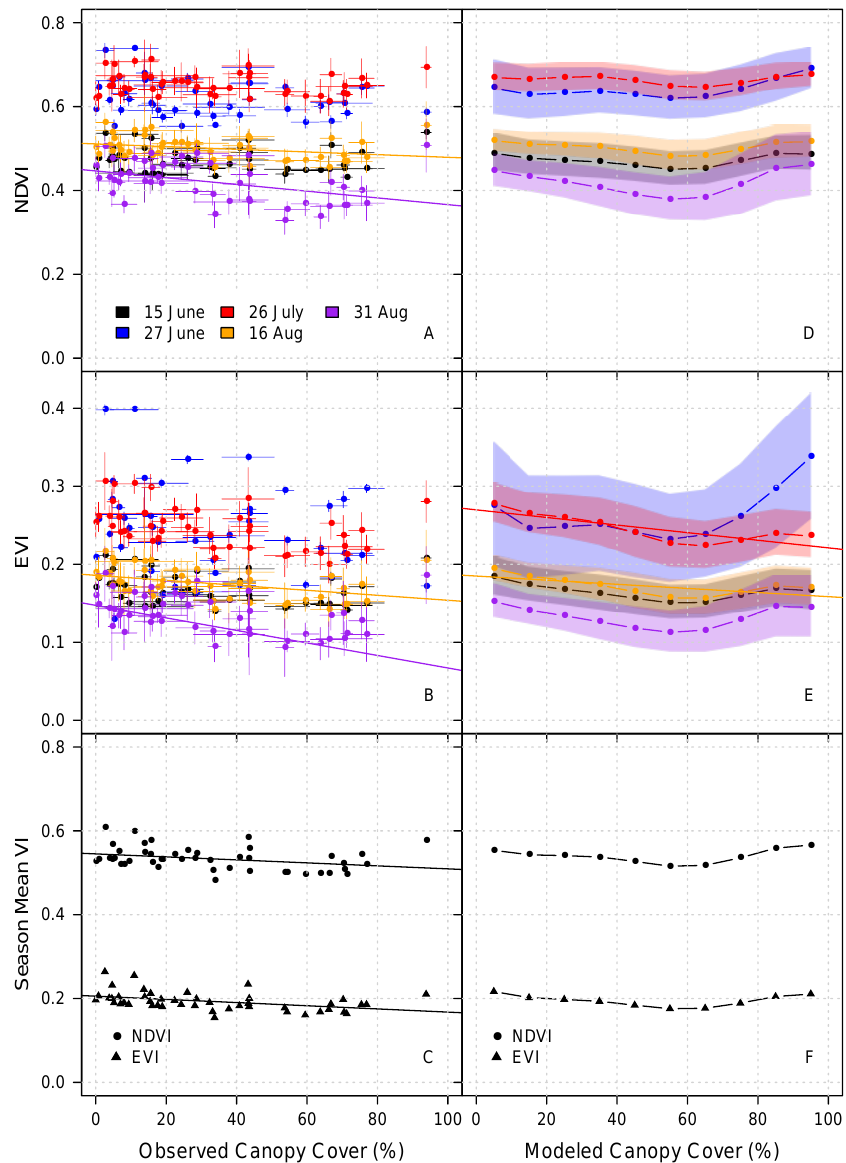
Figure 8. Relationships between observed canopy cover and PlanetScope NDVI ( A ) and EVI ( B ) across all 46 forest stands for five days during the growing season, and also for both indices averaged across the growing season ( C ). Plot whiskers show the standard error of mean observed canopy cover, and the standard deviation of NDVI / EVI for all pixels with centers located within 15 m of the stand center. Plots ( D – F ) show the same, but with modeled canopy cover aggregated into bins of 10%. Shaded polygons represent the standard deviation of NDVI / EVI within each canopy cover bin. In all plots, trend lines show significant ( p < 0.05) linear relationships between canopy cover and NDVI / EVI . Absence of trendlines indicates no significant relationship.